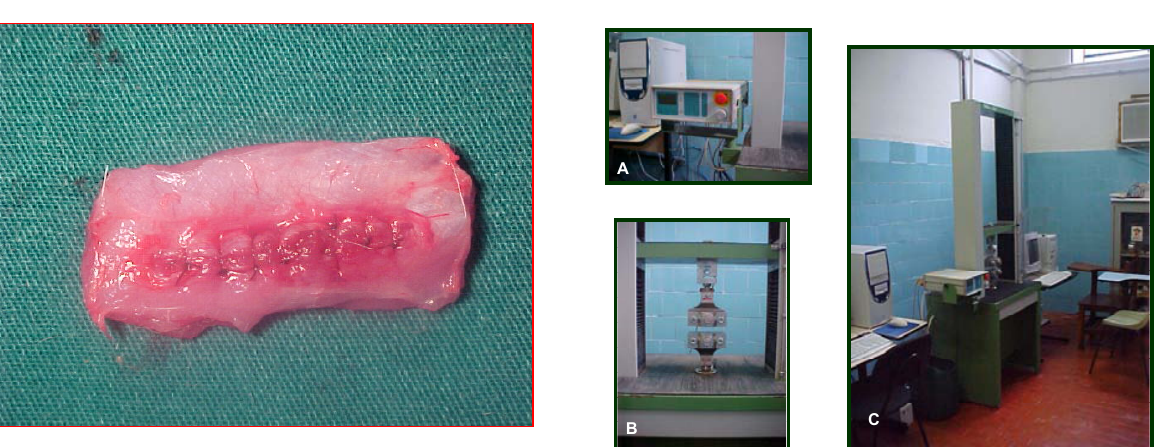
FIGURA 2 - Peça cirúrgica excisada em todo a espessura da parede abdominal FIGURA 3 – Máquina universal de ensaios. LEGENDA: A) Controle digital; B) Garras para tração; C) Sala de